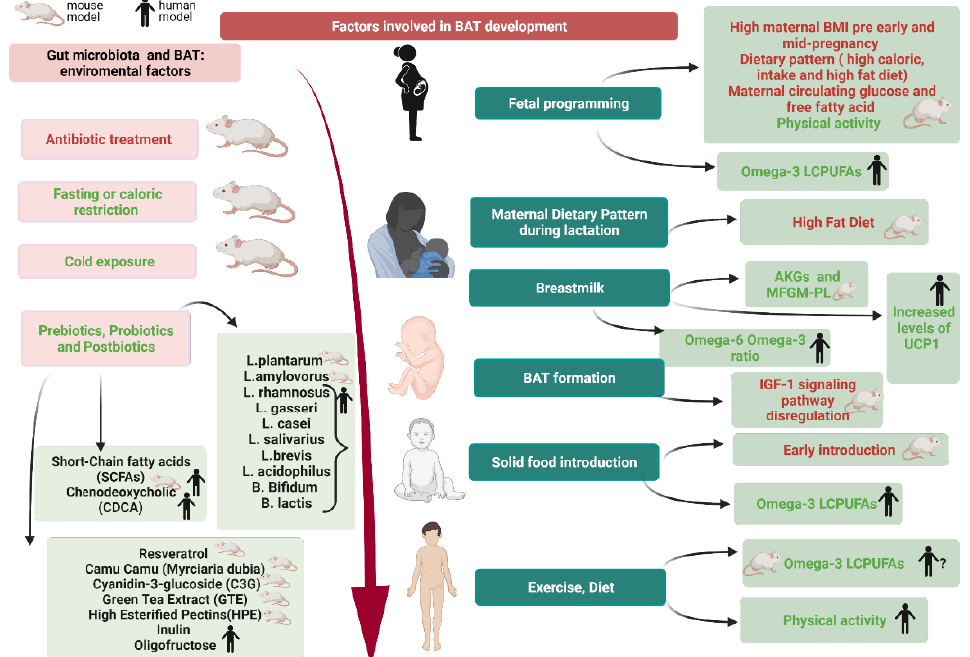
Figure 4. Factor involved in (brown adipose tissue) BAT development. In humans, modulation of BAT occurs during gestation and continues during lactation through lifestyle and maternal BMI. A preterm or low birth weight babies may have a dysregulation of the IGF-1 pathway. Breast milk rich in AGKs and MFGM-PL appears to promote BAT. An early introduction of solid food (before 4-month-old age) is related to a lower activity of the sympathetic nervous system on BAT. Later, in childhood and adolescence exercise and an intake of omega-3 seems to promote BAT development. Gut microbiota can be modulated by environmental factors that appear to promote BAT and its activation (cold exposure, fasting or caloric restriction, prebiotics, probiotics, postbiotics). Made by © BioRender 2021.